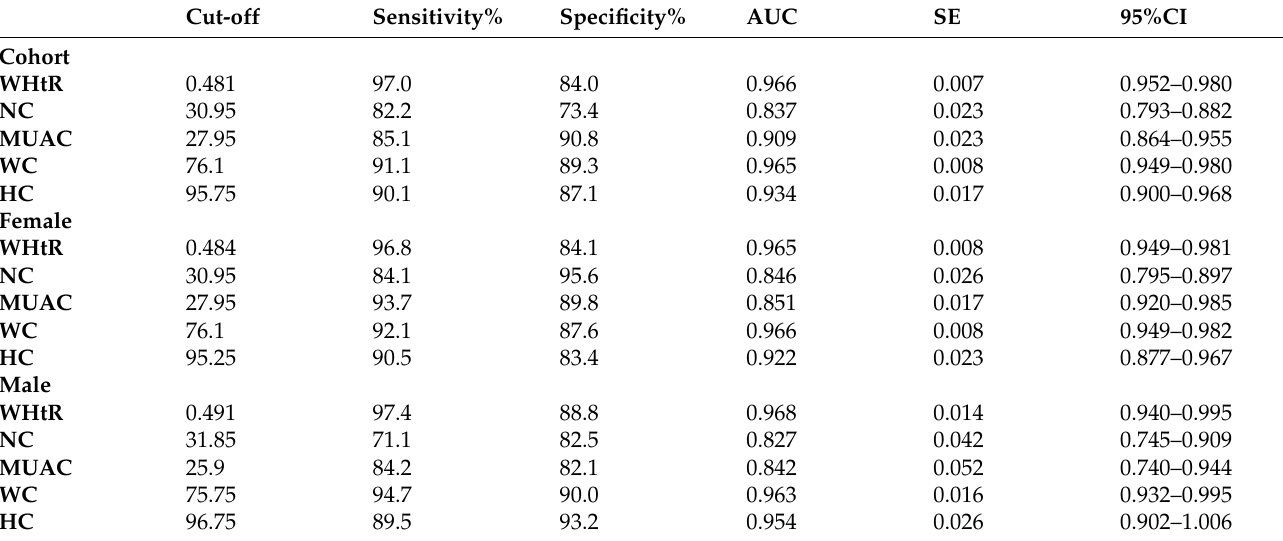
Table 6. Optimal cut-off, sensitivity, specificity, SE and area under the ROC curves for anthropometric indices in predicting obesity in males, females and cohort using